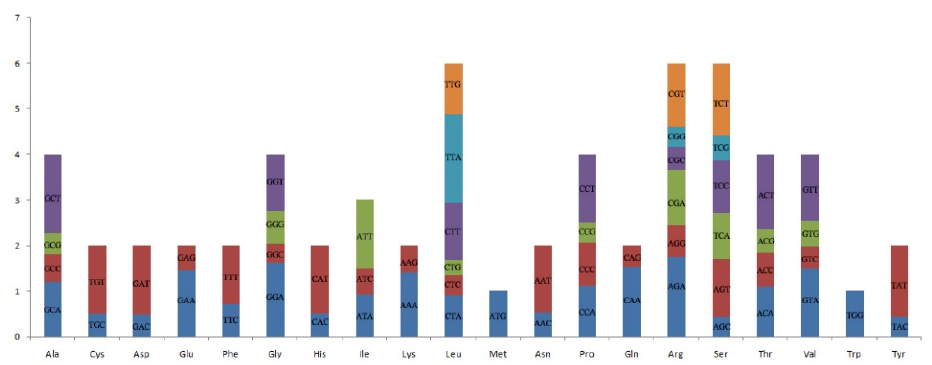
Figure 2. Codon content of 20 amino acids in all protein-coding genes of the D. farinosus cp genome.